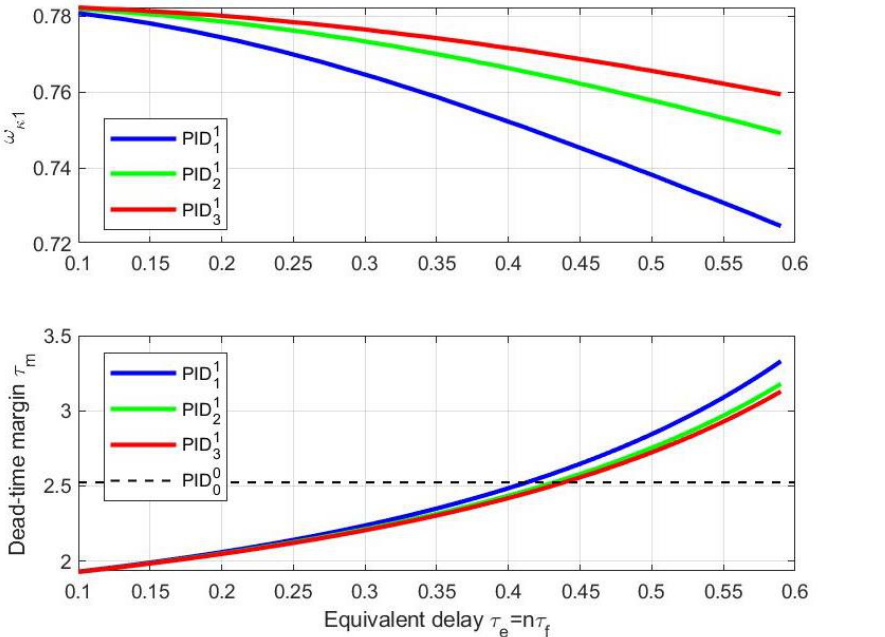
, PID 1 , and PID 1 controllers for T dp = 1 2 3 1